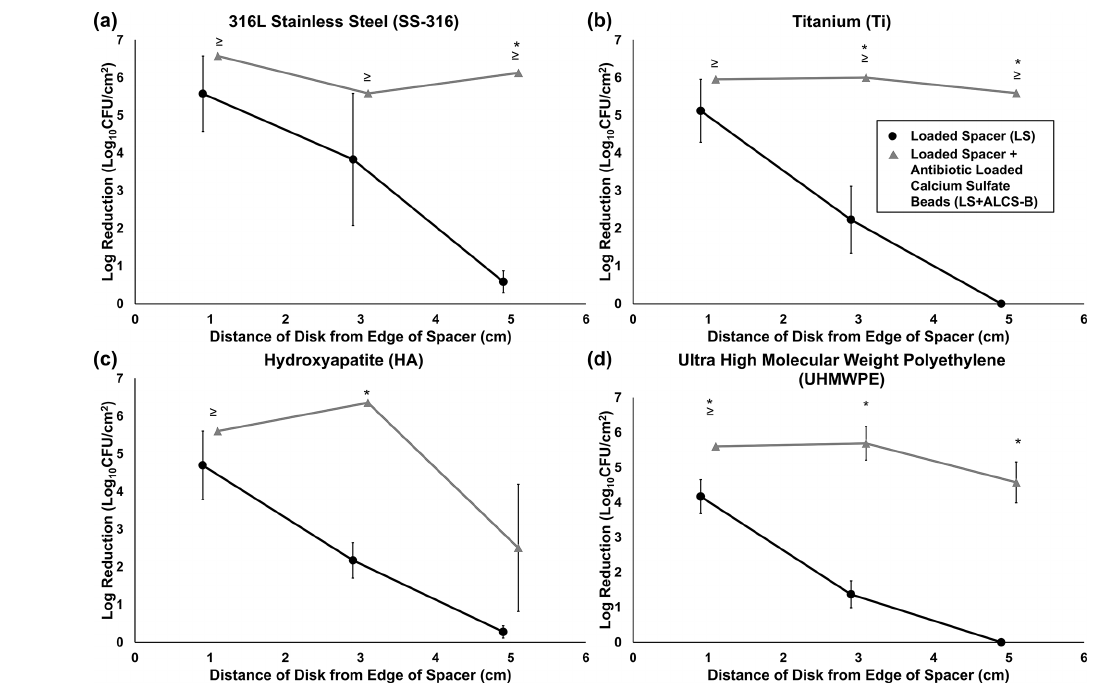
Figure 4. Log reduction of P. aeruginosa Xen41 biofilms, after being grown for 3d in TSB media and then introduced into the large plate model against one of three antibiotic conditions for 5d. CFU counts of SS-316 (a) , Ti (b) , HA (c) , and UHMWPE (d) from the biofilm- colonized discs, varying in distance from the edge of the PMMA spacer, were compared to those on an unloaded spacer (US) control. ≥ denotes discs eradicated of biofilm bacteria to below the CFU detection limit (3.54log 10 CFU/cm 2 ) and indicates that the reduction could be greater than or equal to the value listed in the graph. * represents statistically significant ( p < 0 . 05) differences in log reductions between LS and LS + ALCS-B antibiotic